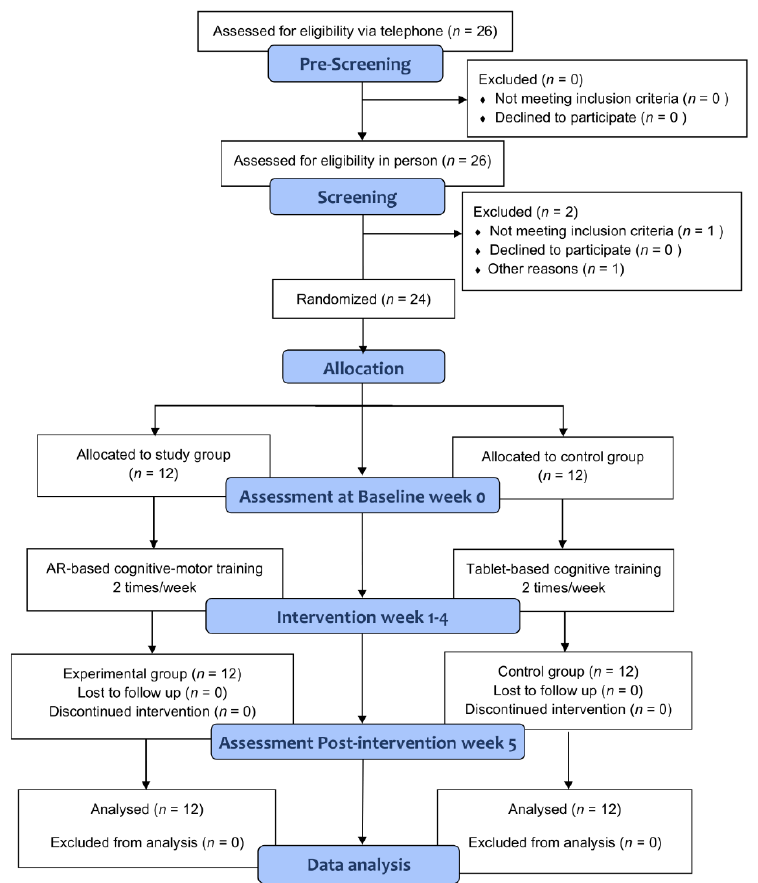
Figure 1. Study flow diagram.